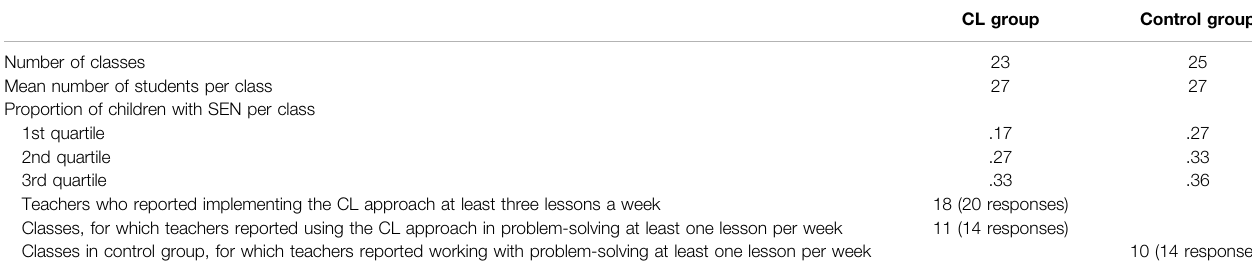
TABLE 1 | Background characteristics of classes and teachers in intervention and control